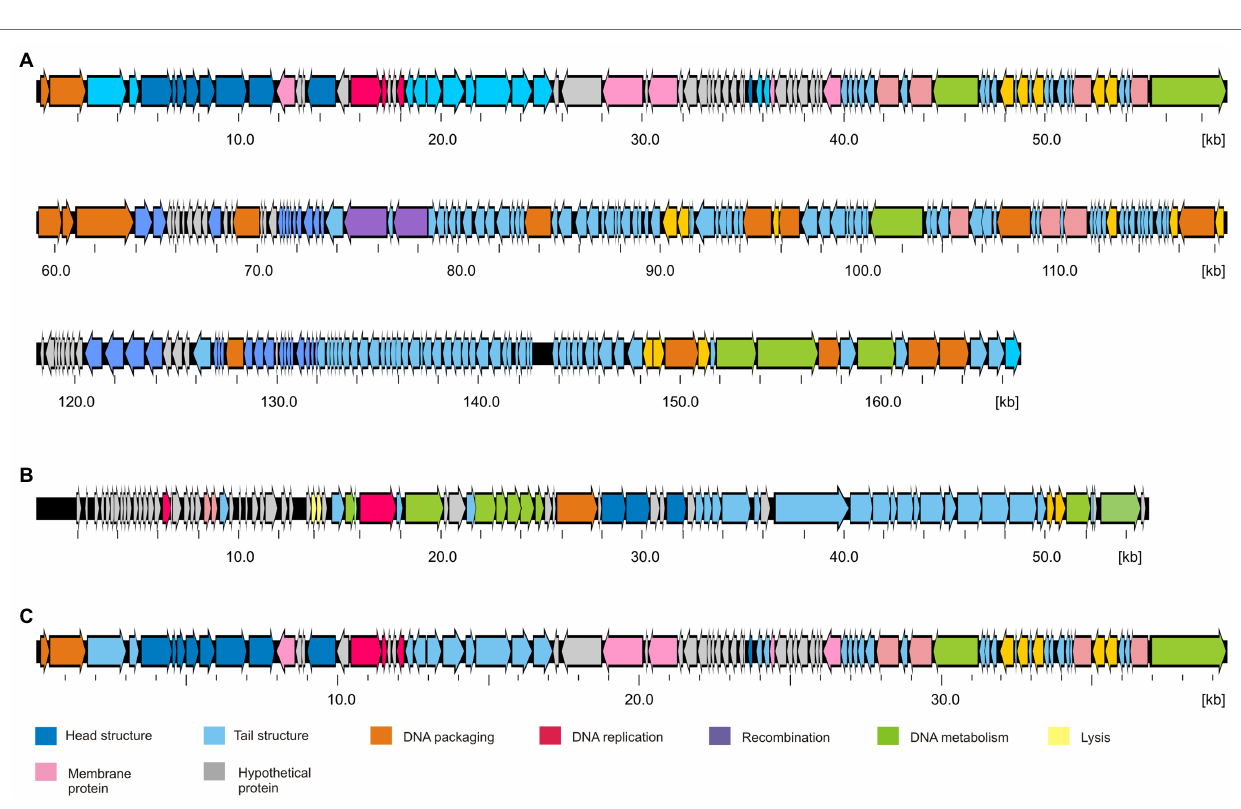
FIGURE 3 | Gene maps of the Y. pseudotuberculosis type phages. (A) PYps2T, (B) PYps23T, and (C) PYps50T. Predicted functions of gene products are indicated by different